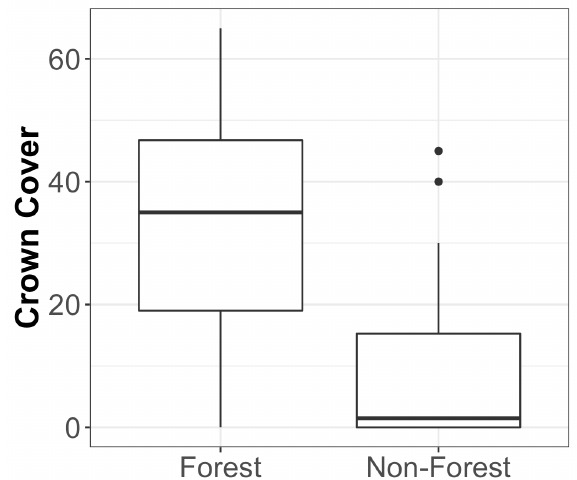
Figure 1. Percent canopy cover for forest and non-forest